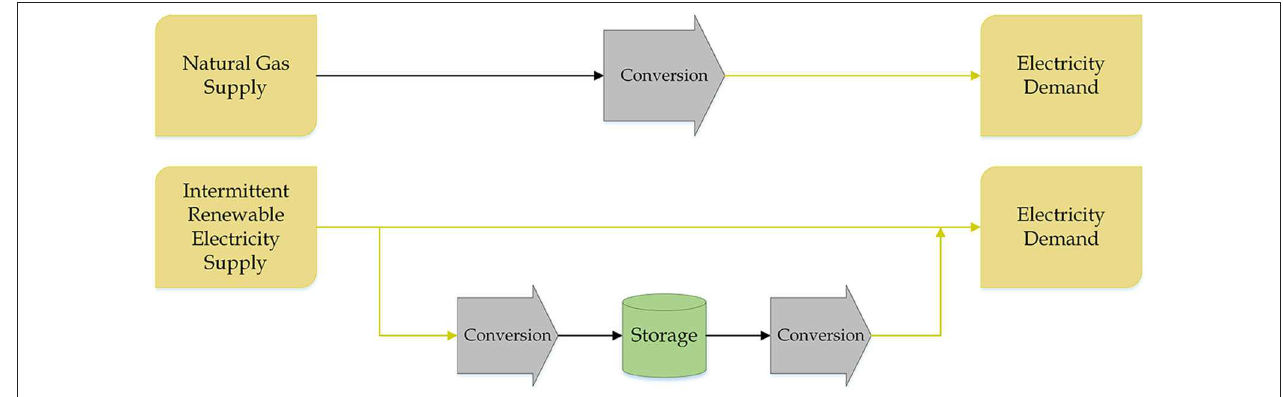
FIGURE 2 | Simplified system designs of the natural gas-based power system (above) and the P-X-P system (below). Yellow lines indicate electricity; black lines indicate chemicals energy carriers.